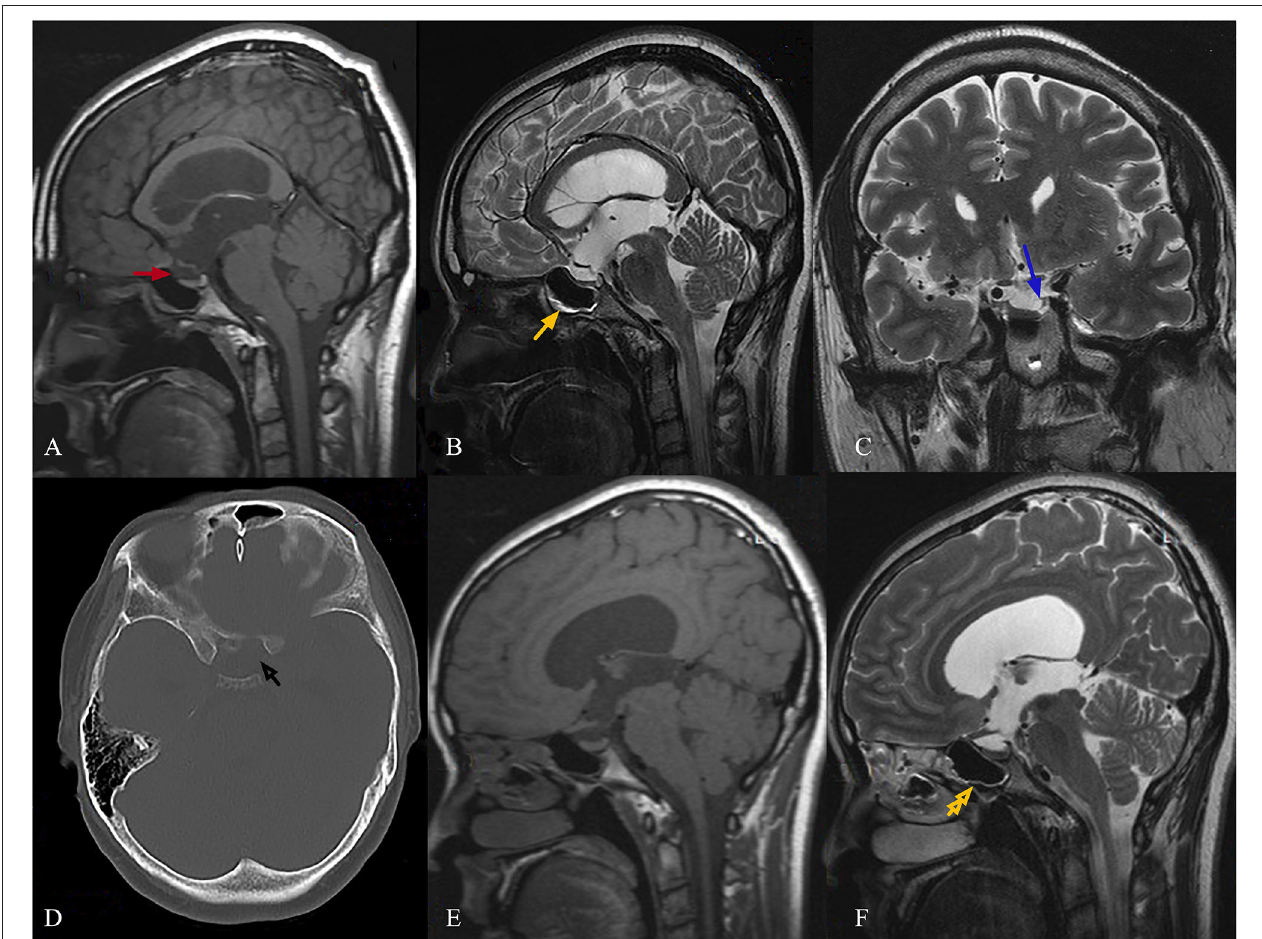
FIGURE 1 | Female, 29-year-old, complained of runny nose for 4 years when bowing her head, and irregular menstruation with infertility for 3 years. The sagittal T1 images show a CSF-filled herniated sac through the bone defect into the sphenoidal sinus [ (A) , red arrow]. The sagittal T2 images show that the fluid accumulated in the sphenoid sinus with a gas-liquid plane [ (B) , yellow arrow]. A bone defect in the body of the sphenoid sinus, which was implicated at the site of the leak, was detected in an axial CT scan [ (D) , black arrow]. The coronal T2 images show the presence of arachnoid pits along the anteromedial aspect [ (C) , blue